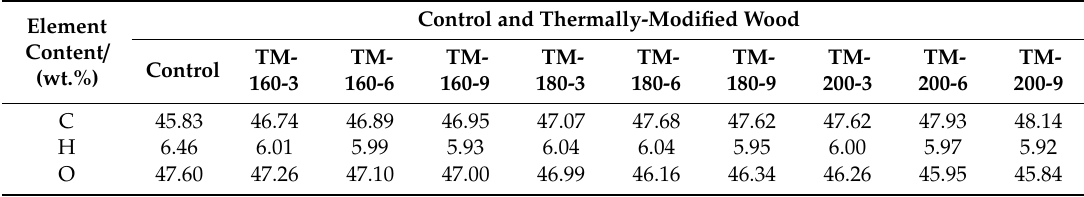
Table 1. Ultimate analysis of the control and thermally-modified wood.